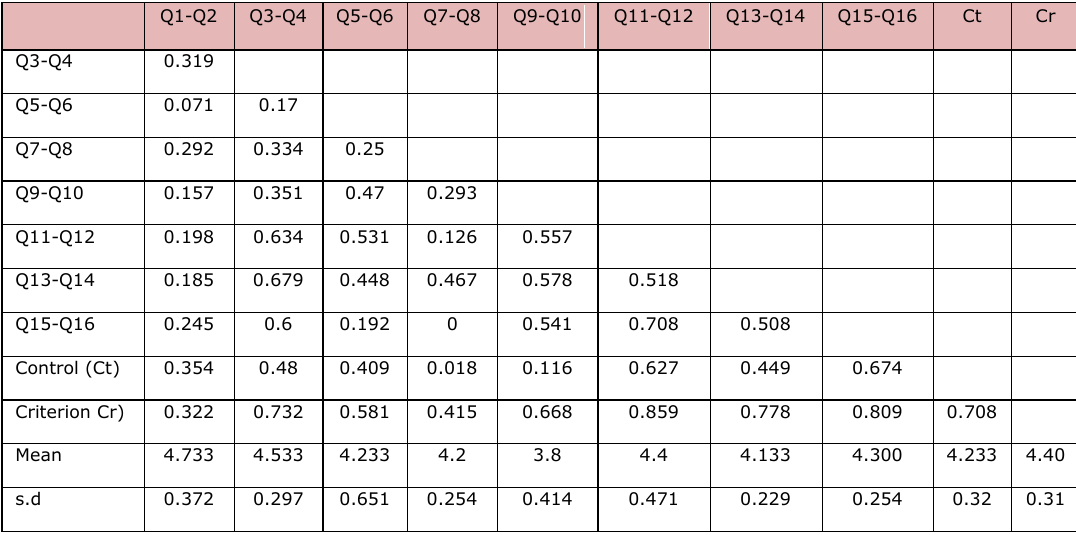
Table 1. “Summary of Correlations, Means and Standard